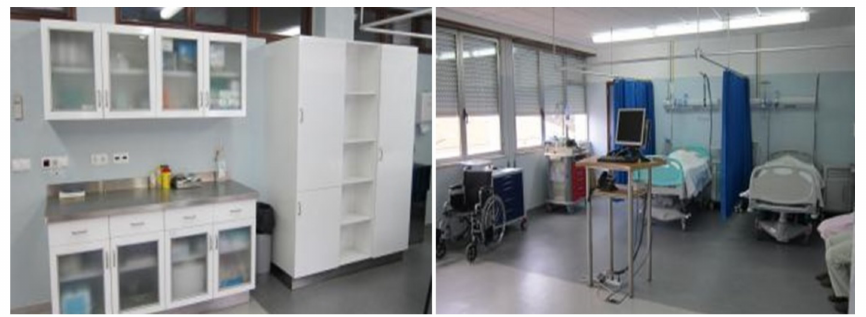
Figure 1. Laboratory setting where the pre-clinical usability assessment tests were